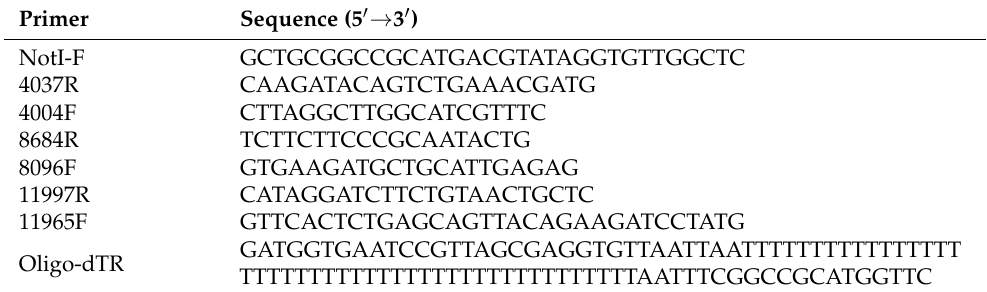
Table 1. Oligonucleotide primers used in the construction of NCV13 infectious cDNA clone.